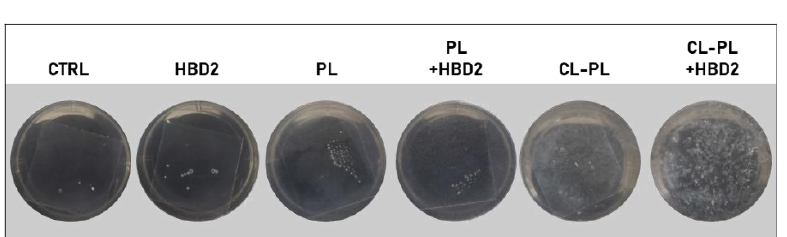
Figure A3. Biofilm structure of PA after treatment with HBD2 and liposomes using PACF. Bacteria were incubated for 18 h with constant agitation in the presence and absence of HBD2 and liposomes alone or combined in 24-well plates. CTRL: solvent control; PL: carrier liposomes; CL-PL: liposomes containing CL. HBD2 concentration was 0.25 µM and CL concentration was 125 µg/mL. Shown are images taken with a black backdrop.